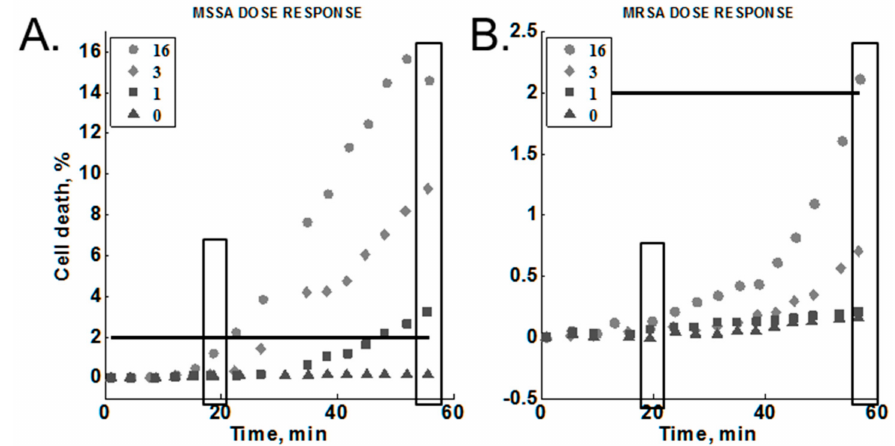
Figure 6. Methicillin-susceptible Staphylococcus aureus (MSSA) vs methicillin-susceptible S. aureus (MRSA) dose-responses for oxacillin. Legend: antibiotic concentration in µ g/mL. 2% black line: provides a relative scale comparison between the two graphs. Rectangles show data selected for Table 3